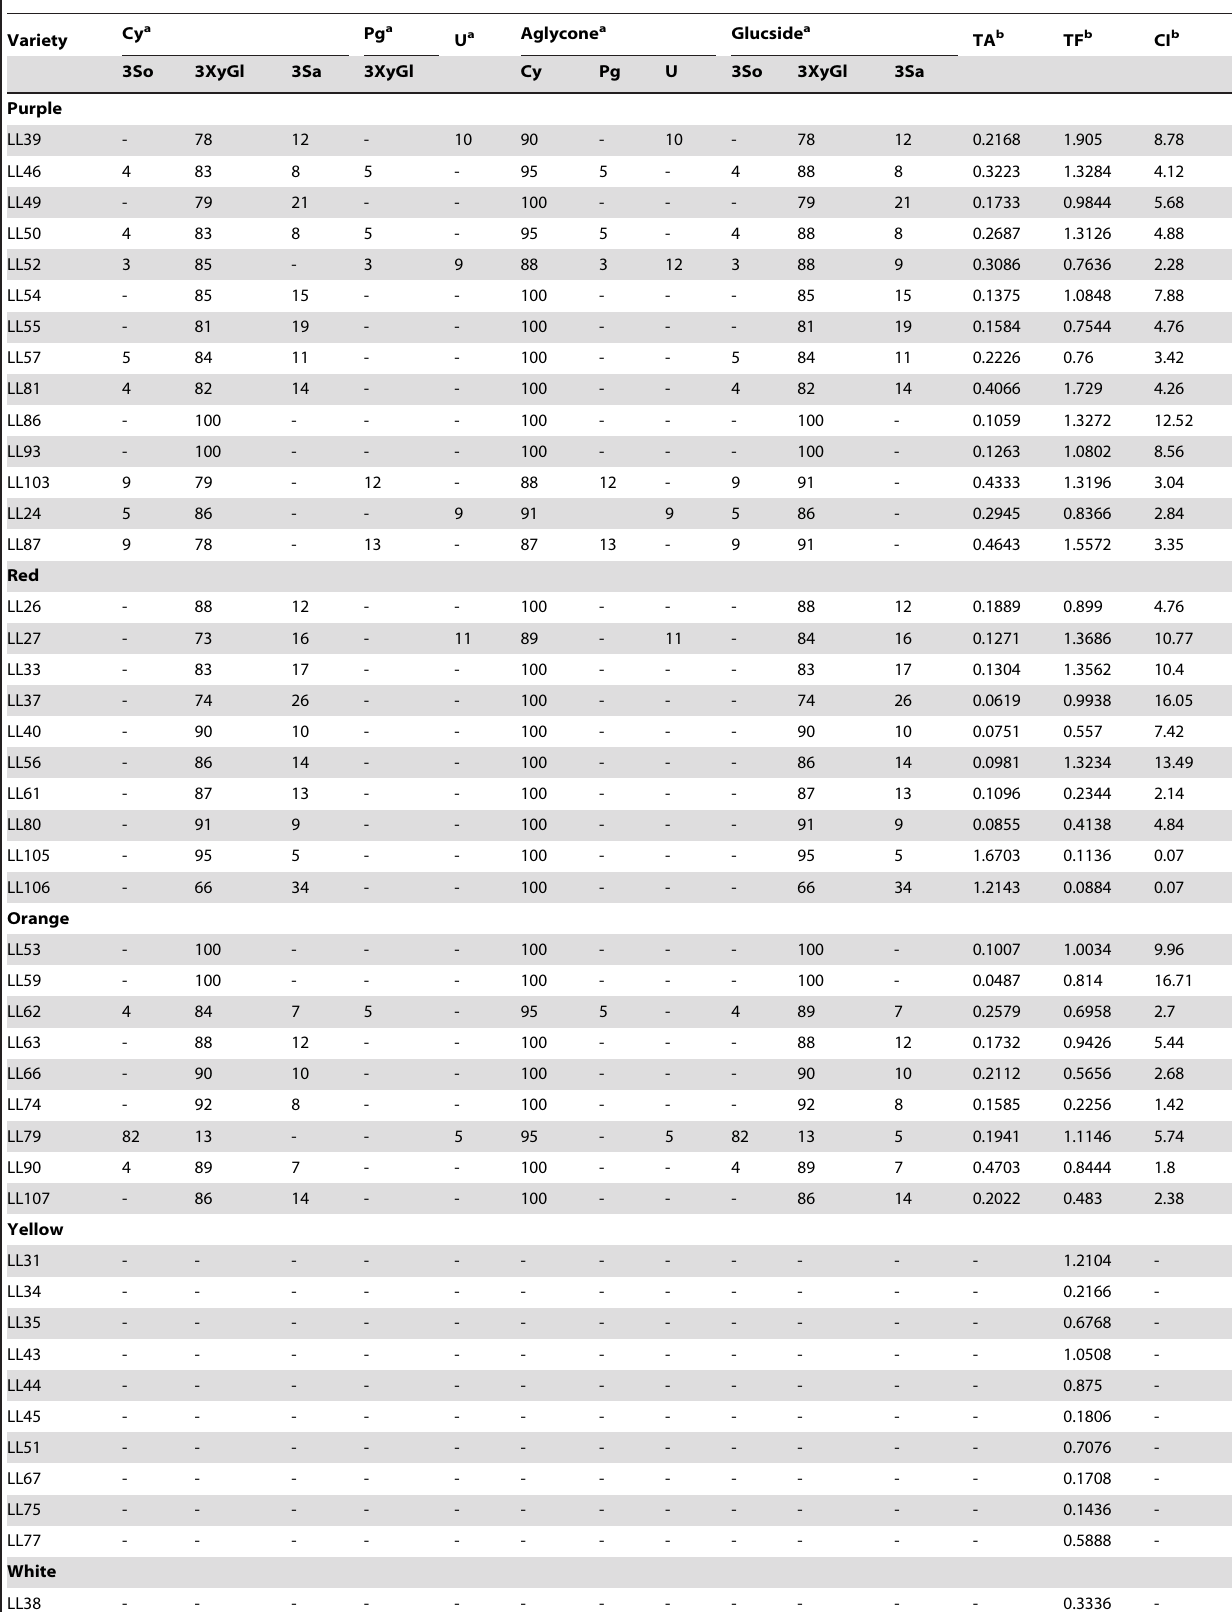
Table 3. Petal anthocyanin mean values (in peak areas %) of 44 Lycoris longituba varieties.